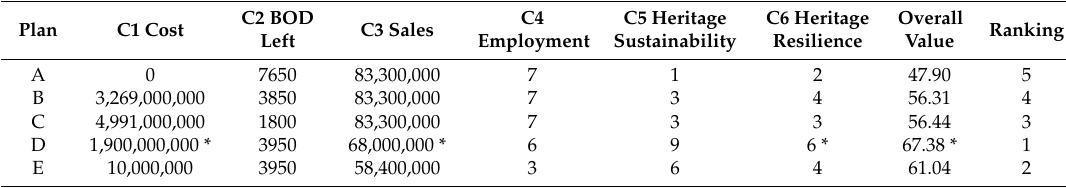
Table 7. The analsis after adjusting the cost/budget of Plan